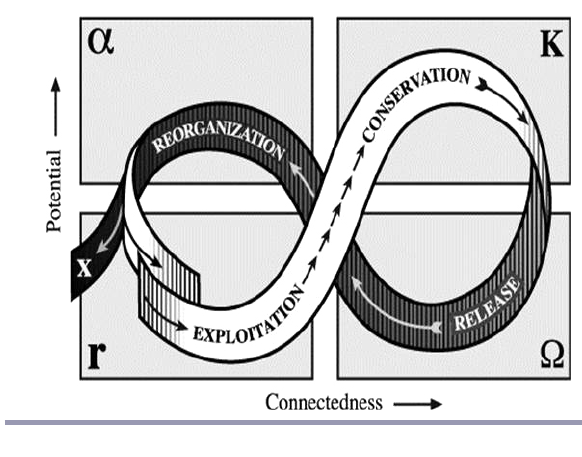
Fig. 1. Adaptive cycle. The tail labeled “x” indicates the potential for the system to undergo a regime shift. From Panarchy by Lance Gunderson and C.S. Holling. Copyright © 2002 Island Press. Reproduced by permission of Island Press, Washington,